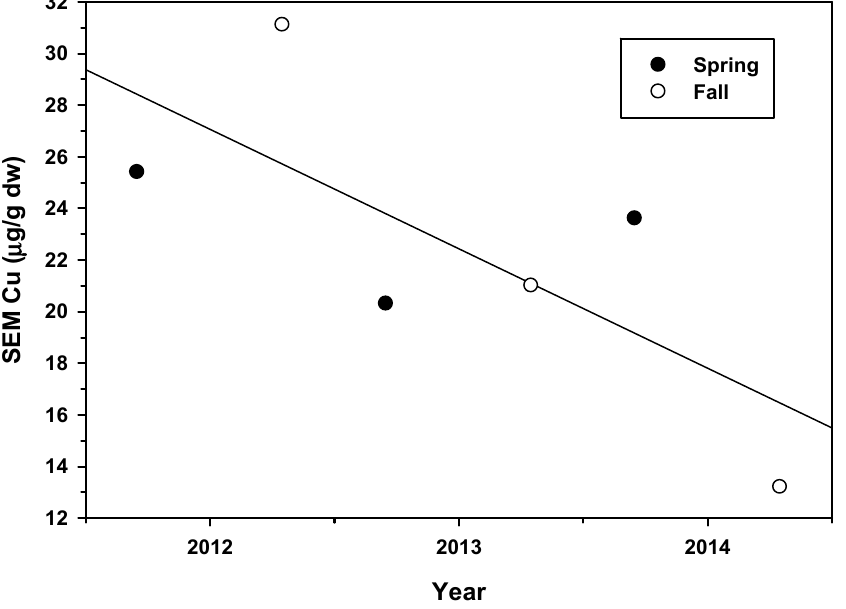
Figure 15. Regression results of sediment SEM copper concentrations (µg/g dry wt) from spring and fall sediment sampling at Cache Slough site CS-09 for the years 2012, 2013 and 2014. (r 2 = 0.545, p = 0.094).